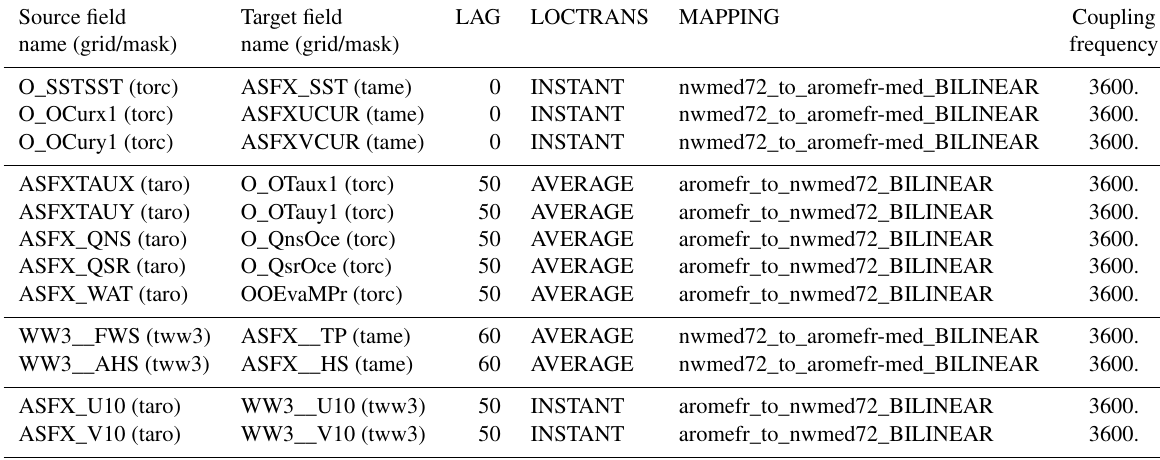
Table A4. OASIS namelist (namcouple) details for the AOW experiment: torc or tww3 is the NWMED72 grid name, taro is the full AROME- France grid name, and tame is the AROME-France grid name masked (to land) outside the northwestern Mediterranean sea